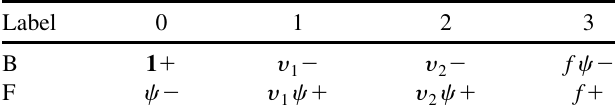
TABLE II. The group-cohomology-state surface-topological , which transforms as T 2 ¼ (cid:1) 1 attached to order with v 1 ; 2 electrons. The (cid:2) value is the action of T 2 on that quasiparticle.